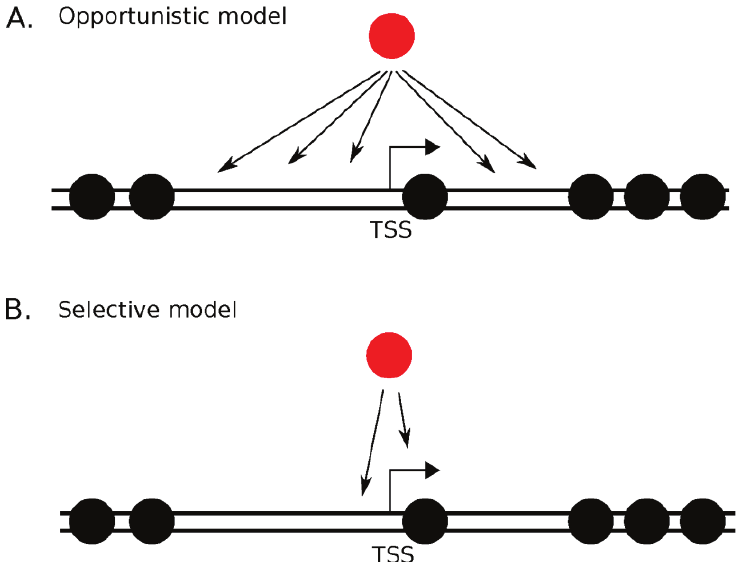
Figure 1. Are histone variants opportunistic occupiers or do they have exclusive